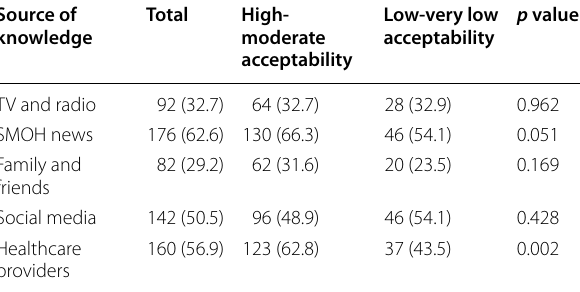
Table 4 The acceptance rate among studied participants relative to different sources of knowledge Source of